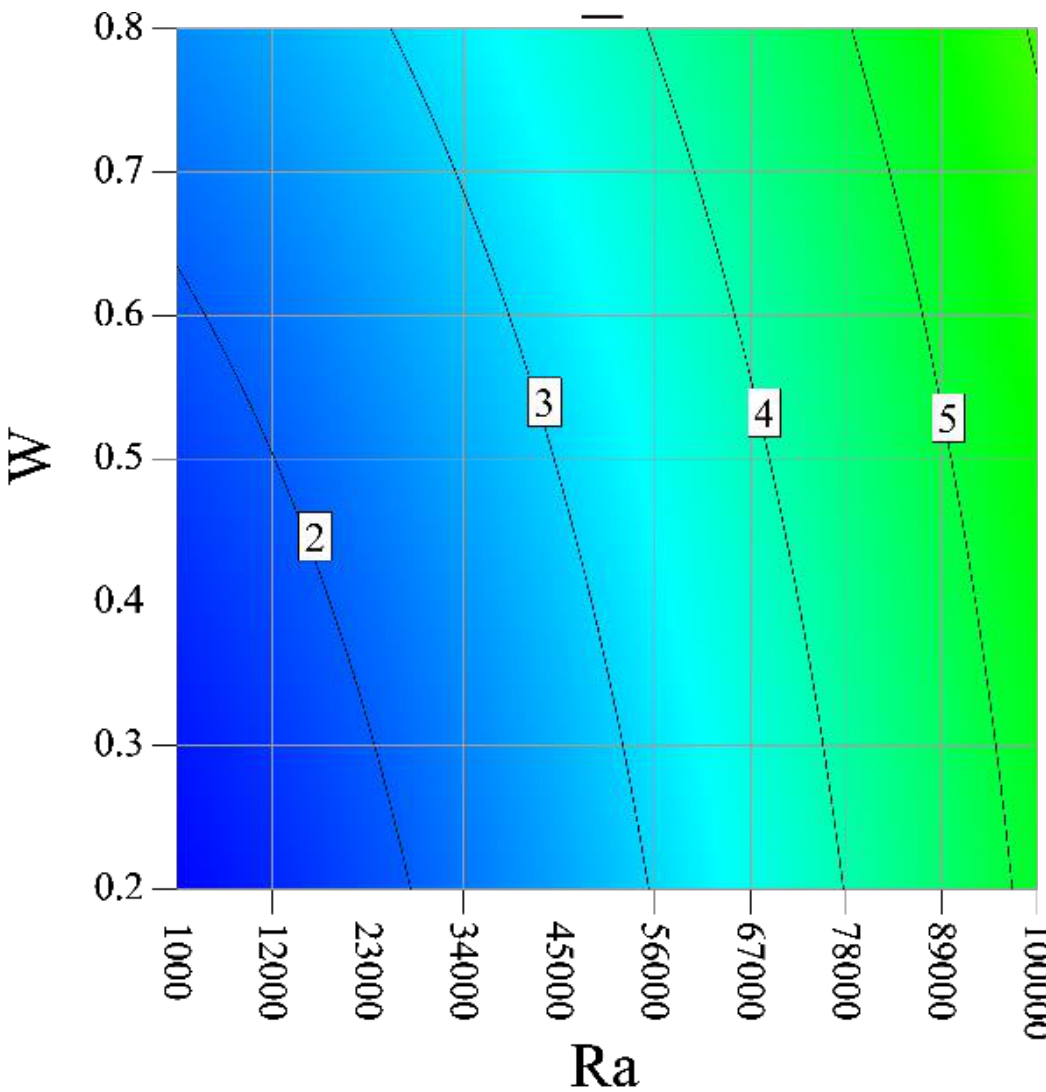
Figure 7. EGN for different Ra and various blade heights when Ha = 30, H = 0.7, and the volume fraction is 0.3% .